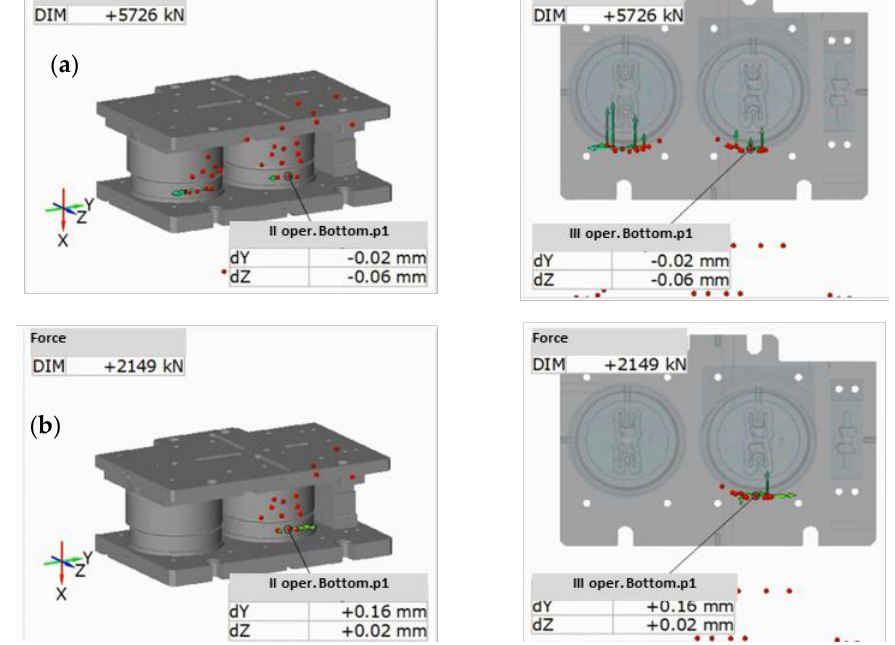
Figure 9. Vectors of lower insert displacements: ( a ) before reaching the lower stroke position, ( b ) after reaching the lower stroke position.